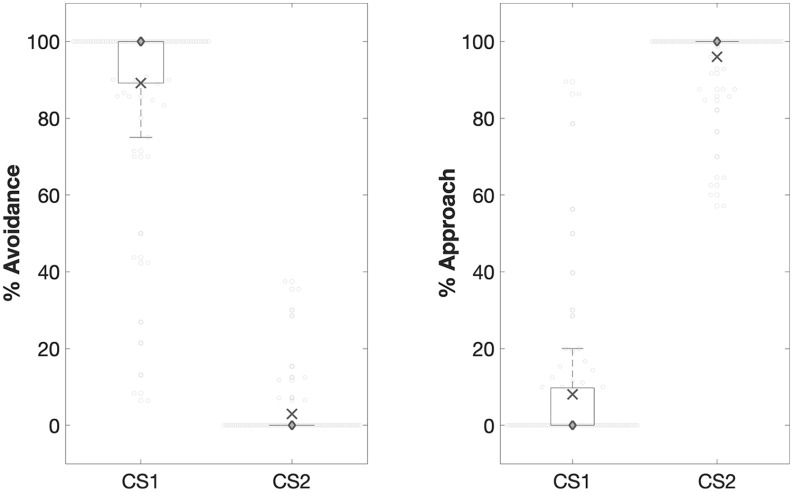
Avoidance learning. CS1 triggered more avoidance than CS2 during avoidance learning. CS2 triggered more approach than CS1. ○ = Individual data points; X = mean; ◊ = median. Edges of the box are the 25th and 75th percentiles. Whiskers extend to extreme value not considered to be an outlier. The absence of a box indicates that the 25th and 75th percentiles overlapped with the median value. **p < .0001.